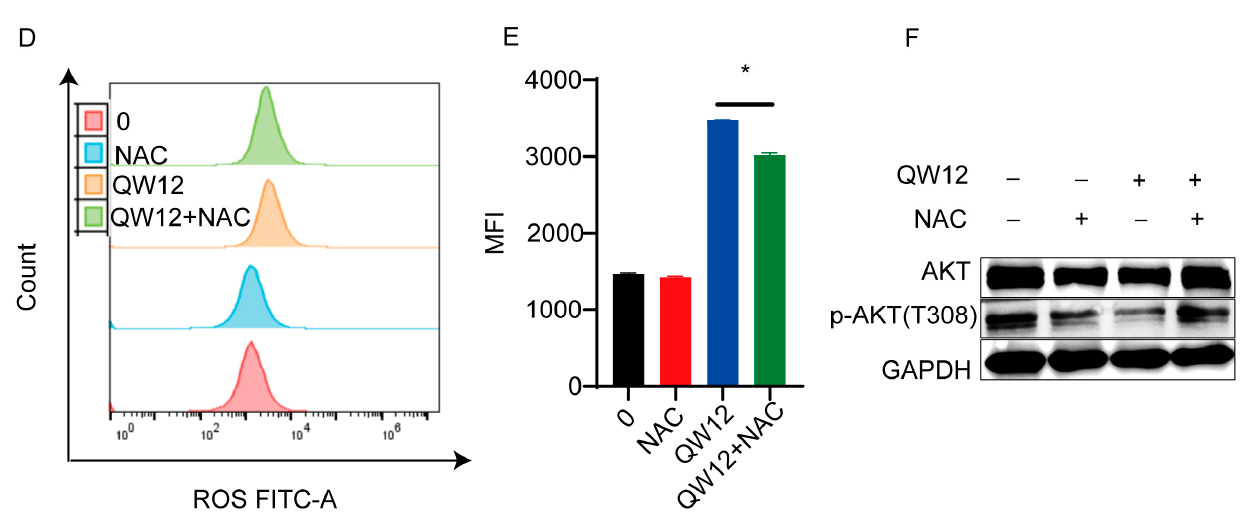
Figure 5. QW12 induces intracellular ROS generation. ( A ) Concentration-dependent induction of the ROS content in HeLa cells by QW12 for 6 h. ( B ) Quantitative statistics of the results in A using the GraphPad software. ( C ) HeLa cells were pretreated with NAC (5 mM, 1 h) prior to incubation with QW12 for 48 h. The results of CCK-8 showed that NAC inhibited the effect of QW12 -induced cytotoxicity. ( D ) HeLa cells were pretreated with NAC (5 mM, 1 h) prior to incubation with QW12 for 6 h. The results of flow cytometry showed that NAC inhibited the effect of QW12 -induced ROS generation. ( E ) Quantitative statistics of the results in D using the GraphPad software. ( F ) HeLa cells were treated in the same way as in ( D ), and Western blot experiments showed that QW12 inhibited AKT (T308) phosphorylation and NAC almost eliminated this effect. Values are presented as means ± SD of three independent experiments. * p < 0.05, ** p <